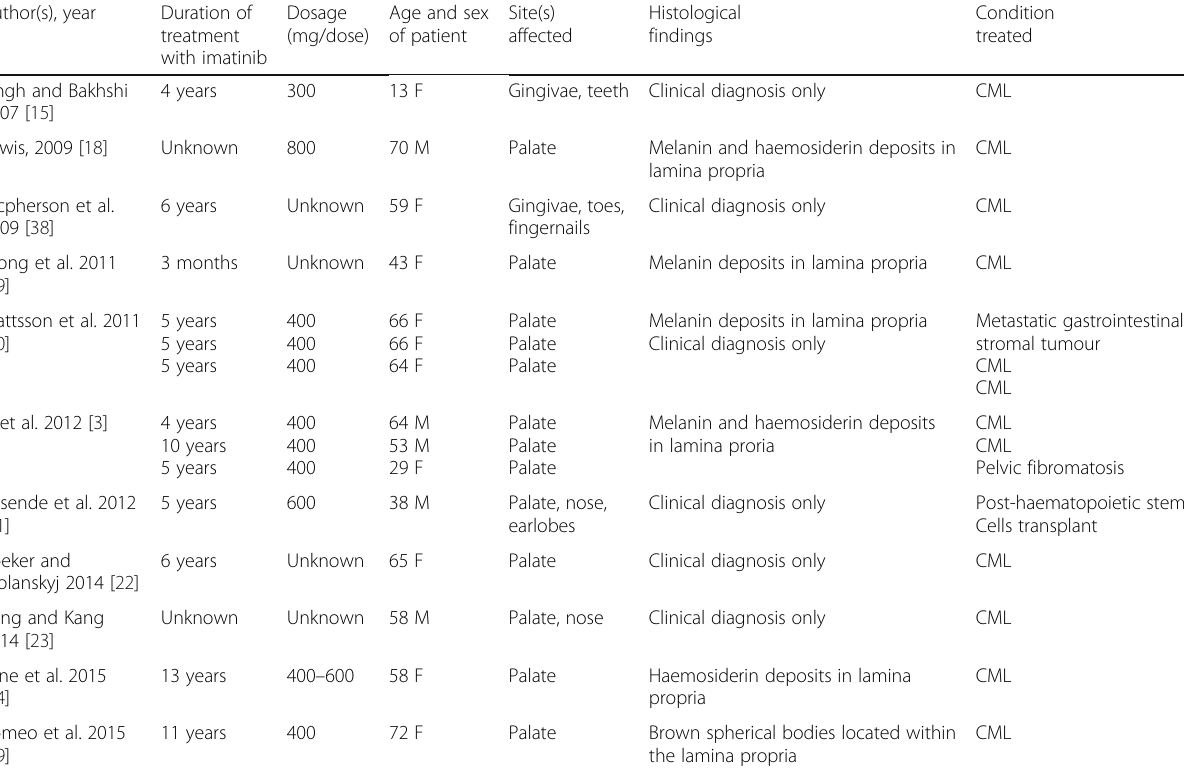
Table 2 Summary of previous case reports on oral mucosal pigmentation associated with imatinib therapy Author(s),